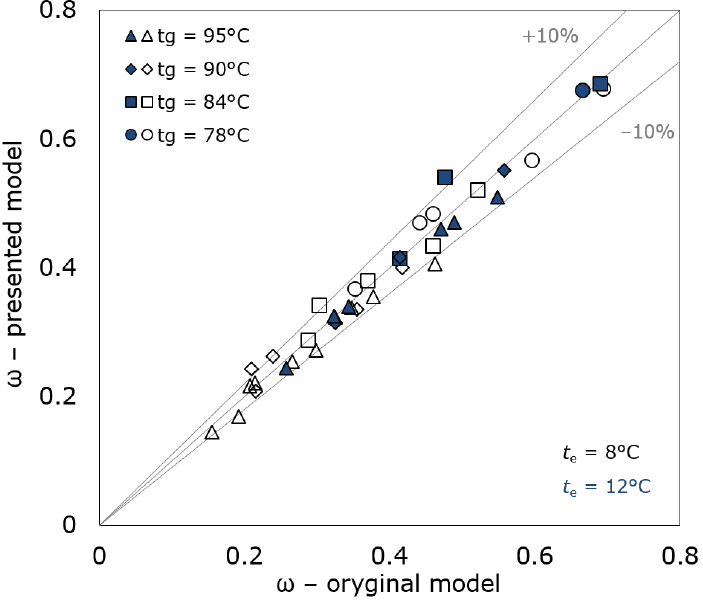
Figure 5. Comparison of the original model presented in [42] and the model performed by the authors.